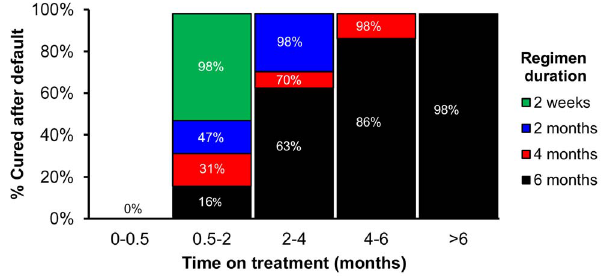
Figure 2. Proportion cured after default, by treatment phase and regimen duration. The proportion cured after default in a six- month treatment regimen was based on outcomes of early TB treatment clinical trials. For each hypothetical shortened treatment regimen, the proportion cured after default is increased according to the proportion of the total treatment duration completed. Detailed examples of calculations are provided in Appendix S1.